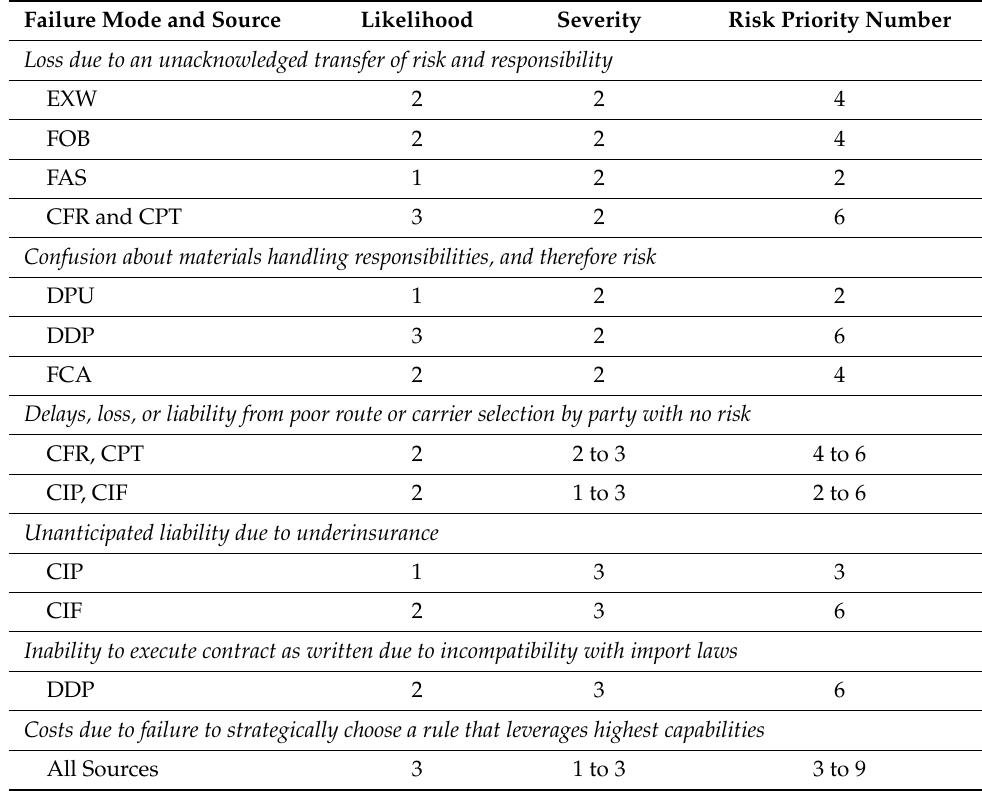
Table 2. Cont. Failure Mode and Source Likelihood